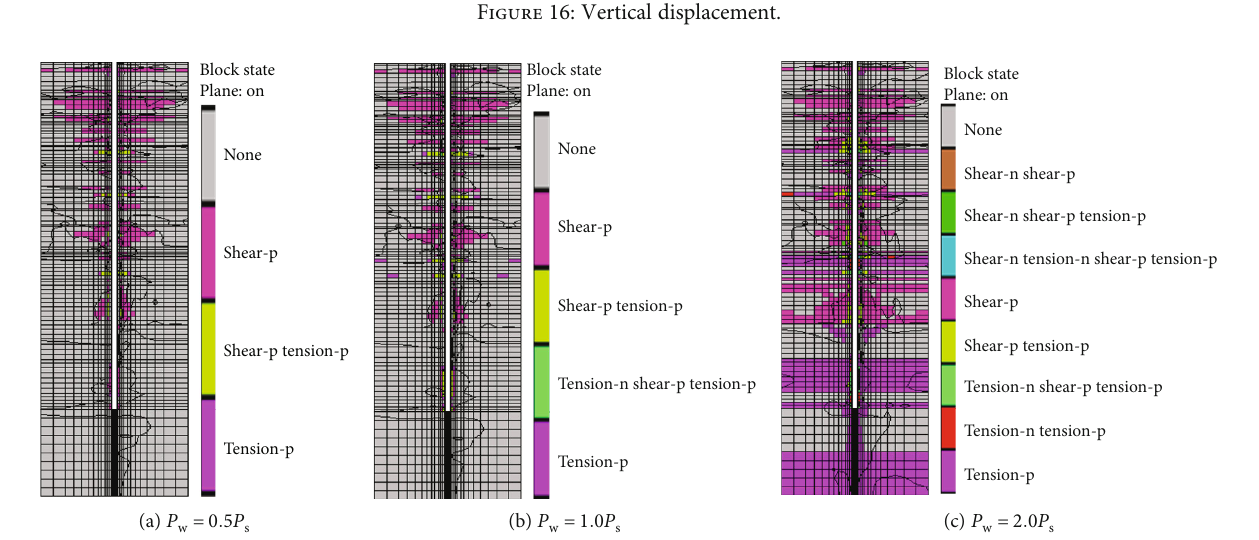
Figure 16: Vertical displacement.